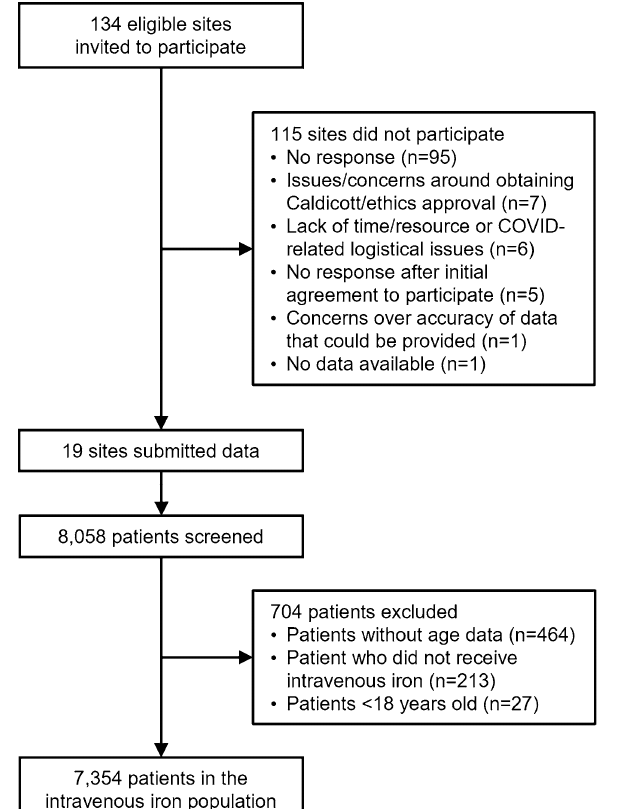
Figure 1. Patient disposition. COVID coronavirus